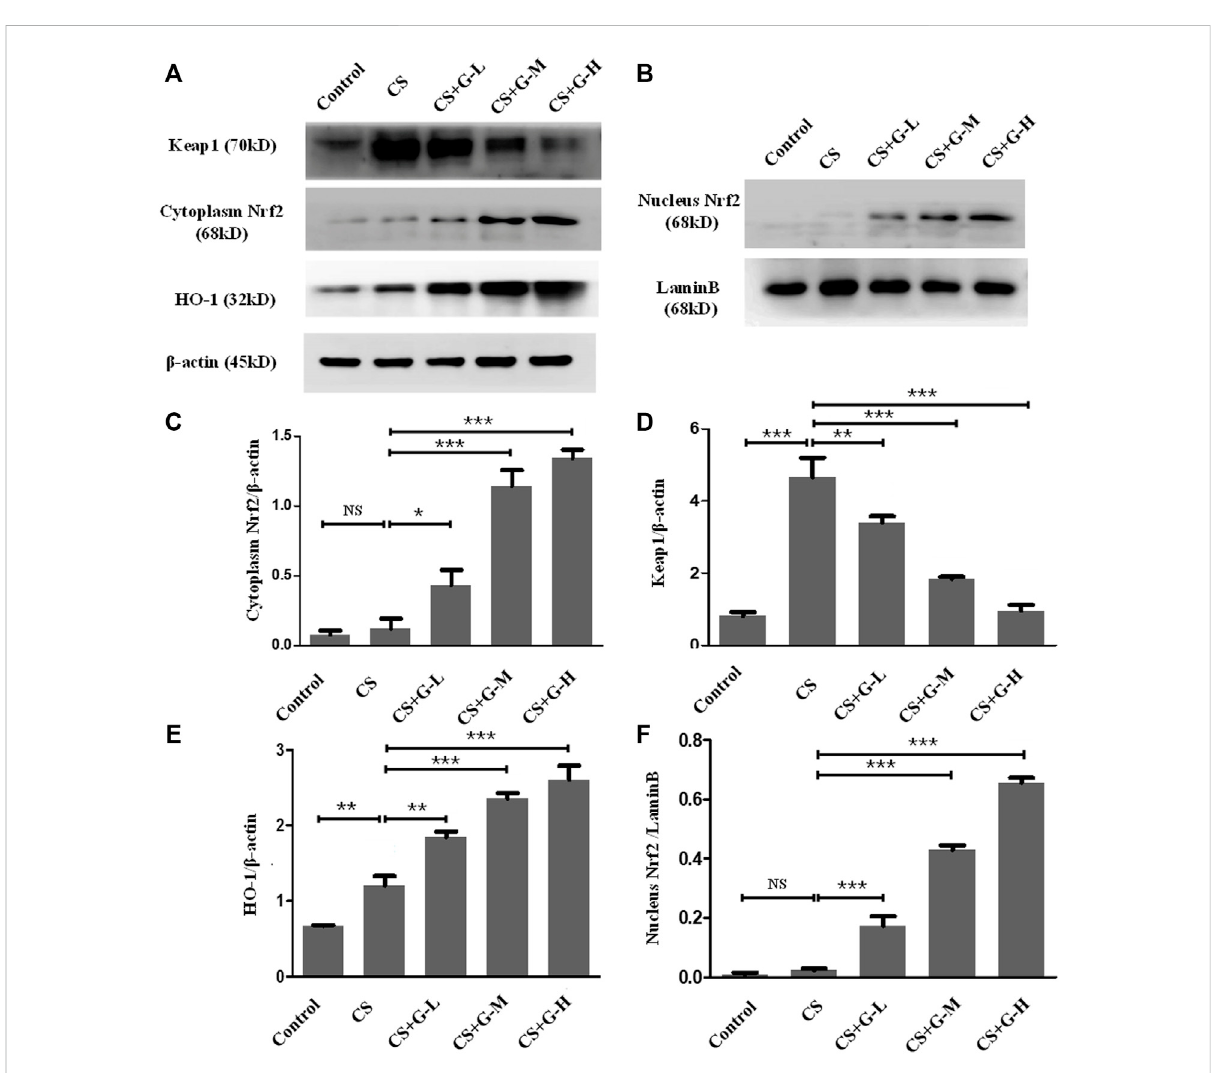
FIGURE 4 GHK-Cu upregulated the Nrf2/Keap1 pathway in mice with chronic cigarette smoke exposure. (A,B) The protein expression of Nrf2/ Keap1 pathway in the cytoplasm and nuclei of lung tissue in mice from different groups was evaluated by western blotting. (C – E) Western blotting analysis ofNrf2 (C) , Keap1 (D) and HO-1 (E) expression in thecytoplasm ofthe lung tissue from mice indifferentgroups. (F) Western blotting analysis of Nrf2 in the nuclei of lung tissue cells in mice from different groups was assessed. * p < 0.05, ** p < 0.01 and *** p < 0.001, and NS means not signi fi cant ( p >